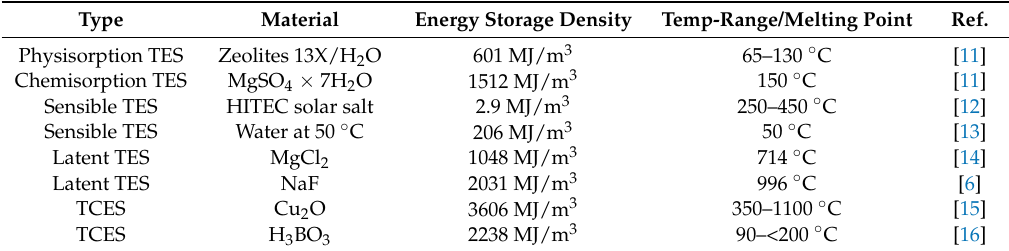
Table 1. Comparison of different thermal energy storage systems